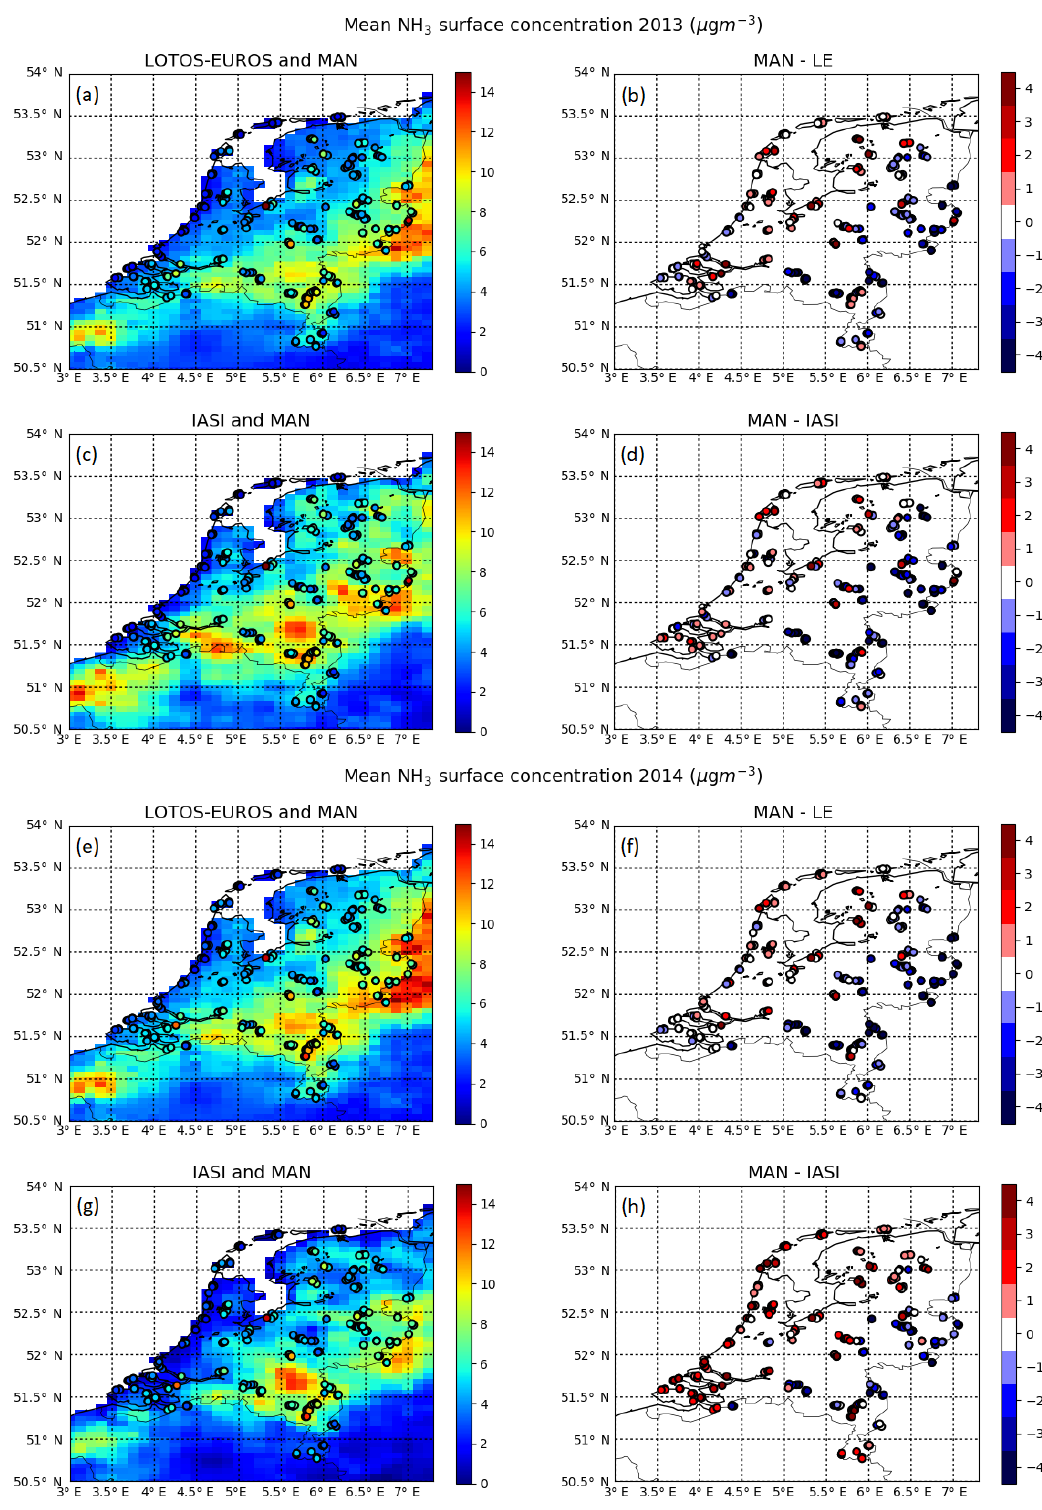
Figure 8. Comparison of the warm season (April–September) mean NH 3 surface concentration in 2013 (a, b, c, d) and in 2014 (e, f, g, h) from LOTOS-EUROS and derived using IASI. The corresponding warm season mean NH 3 surface concentrations measured by the MAN stations are plotted on top of the left figures. The right figures depict the differences between the